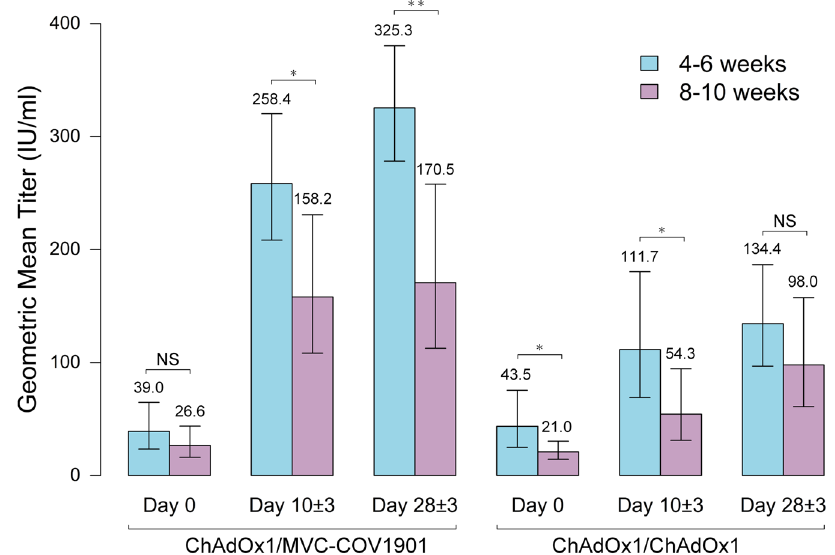
Fig. 4 | Comparisons of antibody titers of short (4 – 6 weeks, n =25) and long (8 – 10 weeks, n =25) vaccine dosing intervals. Neutralizing antibody titers were measured by ELISA-based method. The values in international units per milliliter (IU/mL) are provided. Data are presented as geometric mean ±95% con fi dence intervals. The signi fi cance between two dose intervals was determined using t test